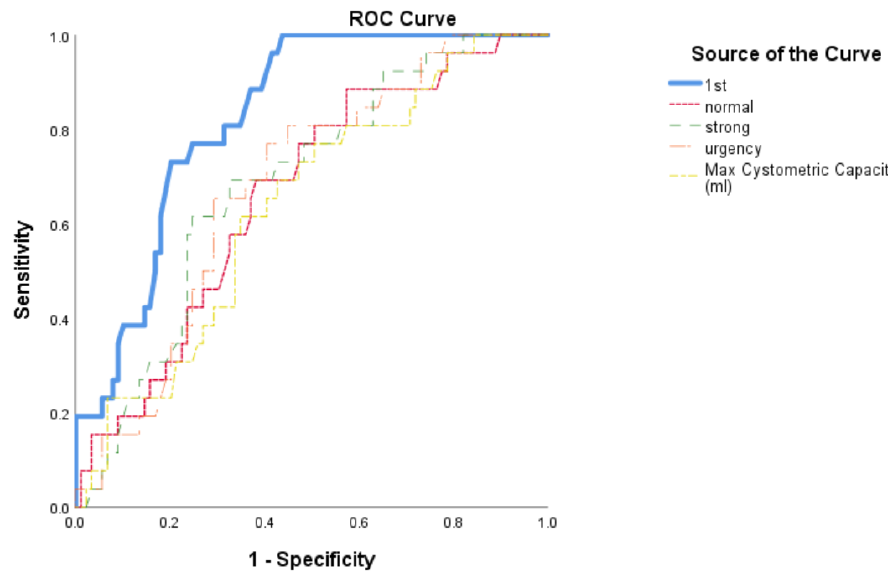
Figure 2. ROC curves of all sensation parameters. First desire to void (1st) with AUC = 0.83, 95% CI = 0.76–0.90, p < 0.001. The Youden index in the ROC curve defines a cutoff of 0.78 at 140 mL for predicting a threshold to outflow obstruction with sensitivity of 83% and specificity of 81%.